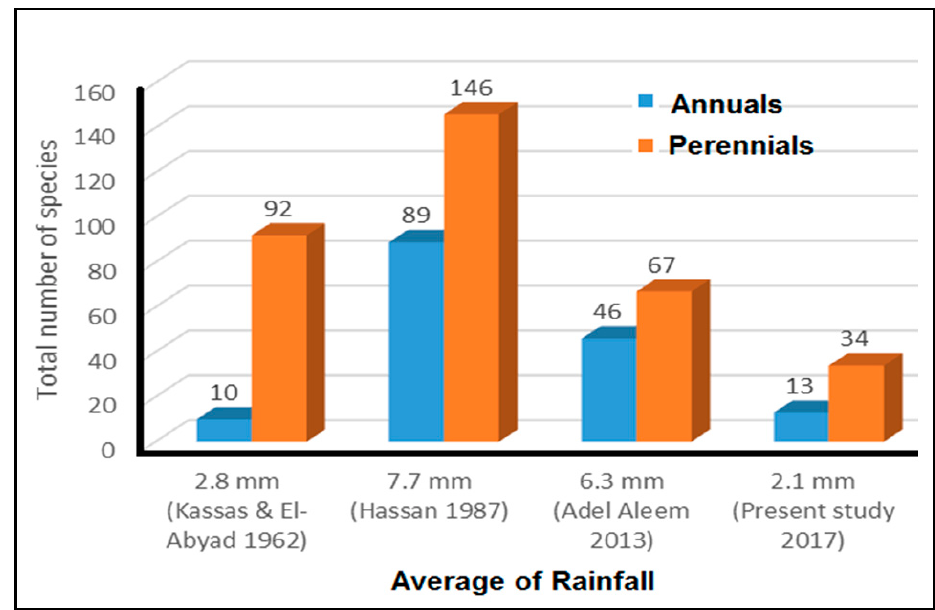
Figure 5. The changes in the numbers of annual and perennial species over the past 55 years (1962–2017) affected by the amount of rainfall (mm). (1962–2017) affected by the amount of rainfall